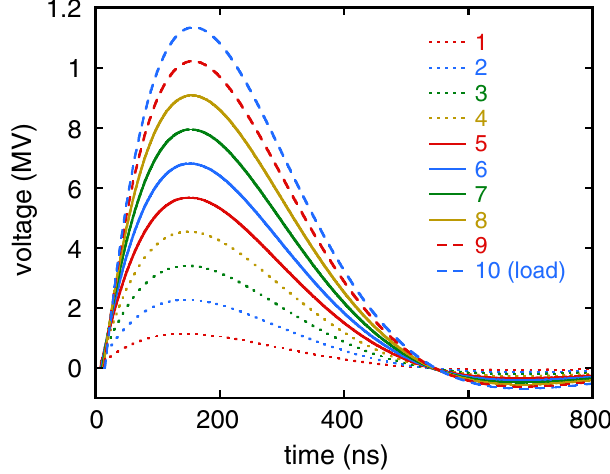
FIG. 12. Simulated voltage time histories at the outputs of the ten transmission-line segments of the ten-stage IMG illustrated by Fig. 11, as given by the circuit model of Fig. 5(a). Since 10 Z ¼ Z , the voltage at the output of the tenth stage is load identical to that at the load.